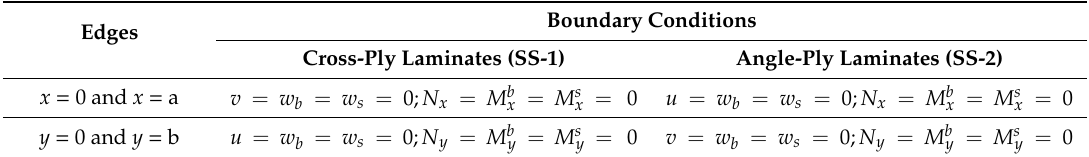
Table 2. Two cases of simply supported boundary